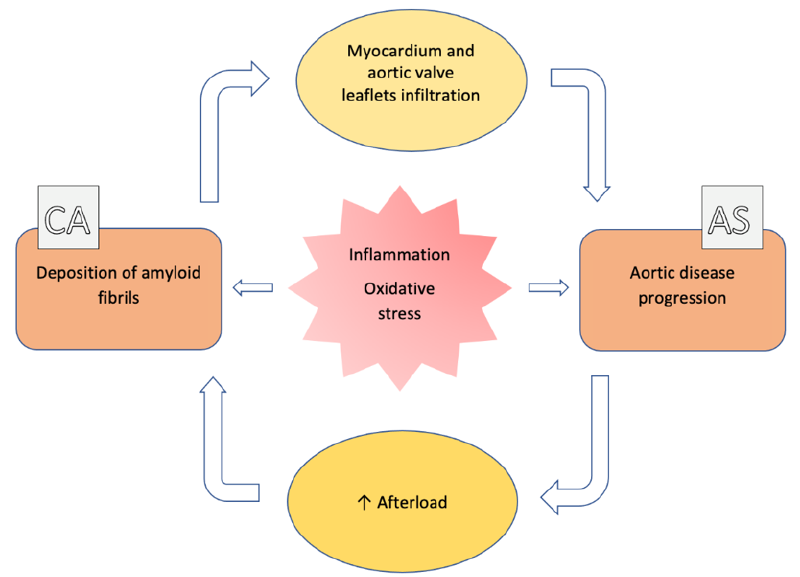
Figure 1. Pathophysiologic correlation between aortic stenosis and cardiac amyloidosis. See the text for details. Table 2. Studies investigating association between aortic stenosis and cardiac amyloidosis. See the text for